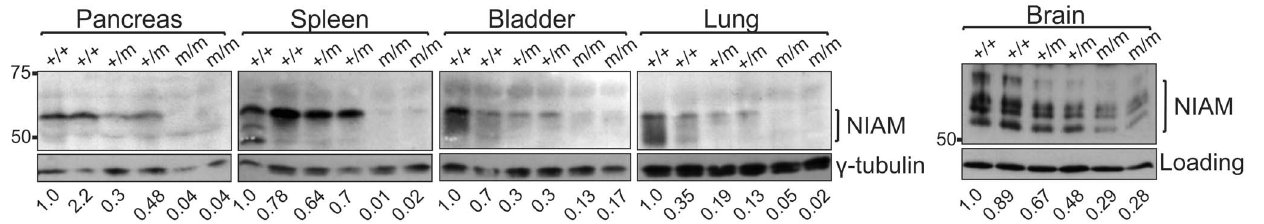
Figure 3. NIAM protein expression in tissues of NIAM mutant mice. NIAM protein levels were assessed in mouse tissues from two mice of each genotype ( + / + , + /m, m/m). Equivalent amounts of protein lysates from spleen, bladder, lung, brain, and pancreas were analyzed by immunoblotting with antibodies to NIAM and c -tubulin. The relative expression of NIAM in each sample, as compared to the first wild-type ( + / + ) sample in each tissue set, is denoted below the lanes. Relative NIAM levels were determined by Image J analysis of band intensities followed by normalization of those values to quantified intensities of the loading control ( c -tubulin or the non-specific band in brain lysates) in each sample.